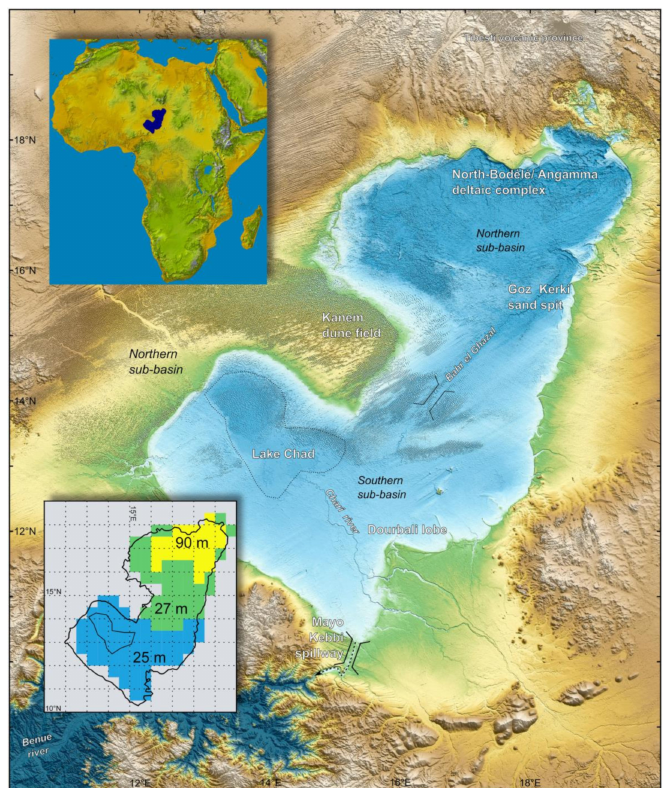
Figure 1. Digital elevation model (SRTM3) of the Chad Basin showing the paleo-extent of Megalake Chad (in light blue), the outline of the Lake Chad in the 1960s (dotted line), and the location of the main areas mentioned in the main text (for more details see [29,40–42]). Upper-left inset: extent of Megalake Chad compared to Africa. Lower-left inset: approximation used to compute the hydro-isostatic rebound related to the drying up of the MLC (the black line represent the 325 m-level line; note the three distinct sub-divisions used to model the load, values refers to their respective mean